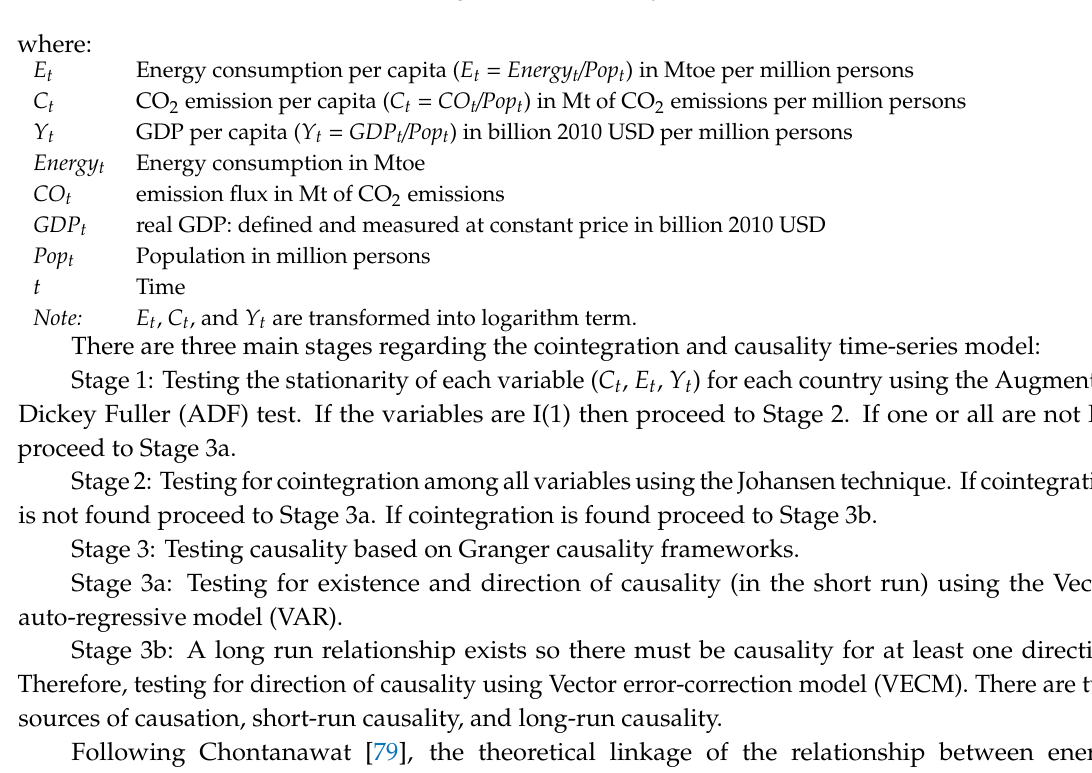
Figure 1. Cointegration and causality time series model.